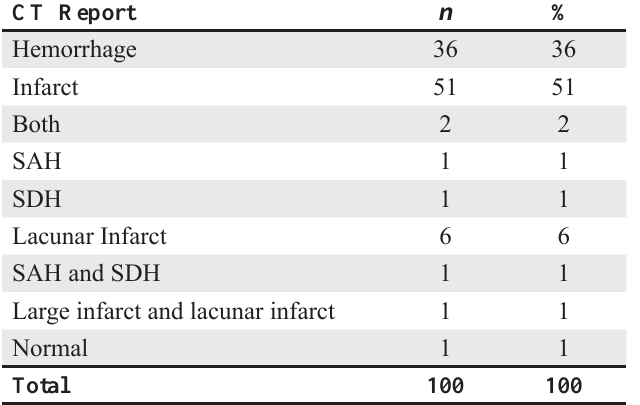
Table 1: CT Scan reports in clinically suspected CVA disease